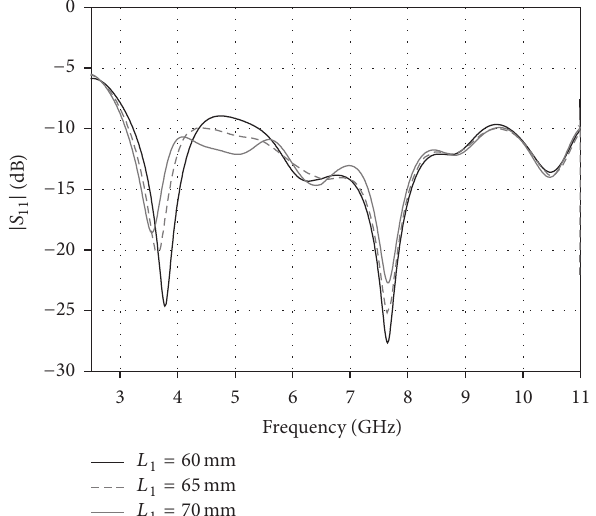
Figure 3: Effect of the gap 𝑔 on the reflection coefficient.